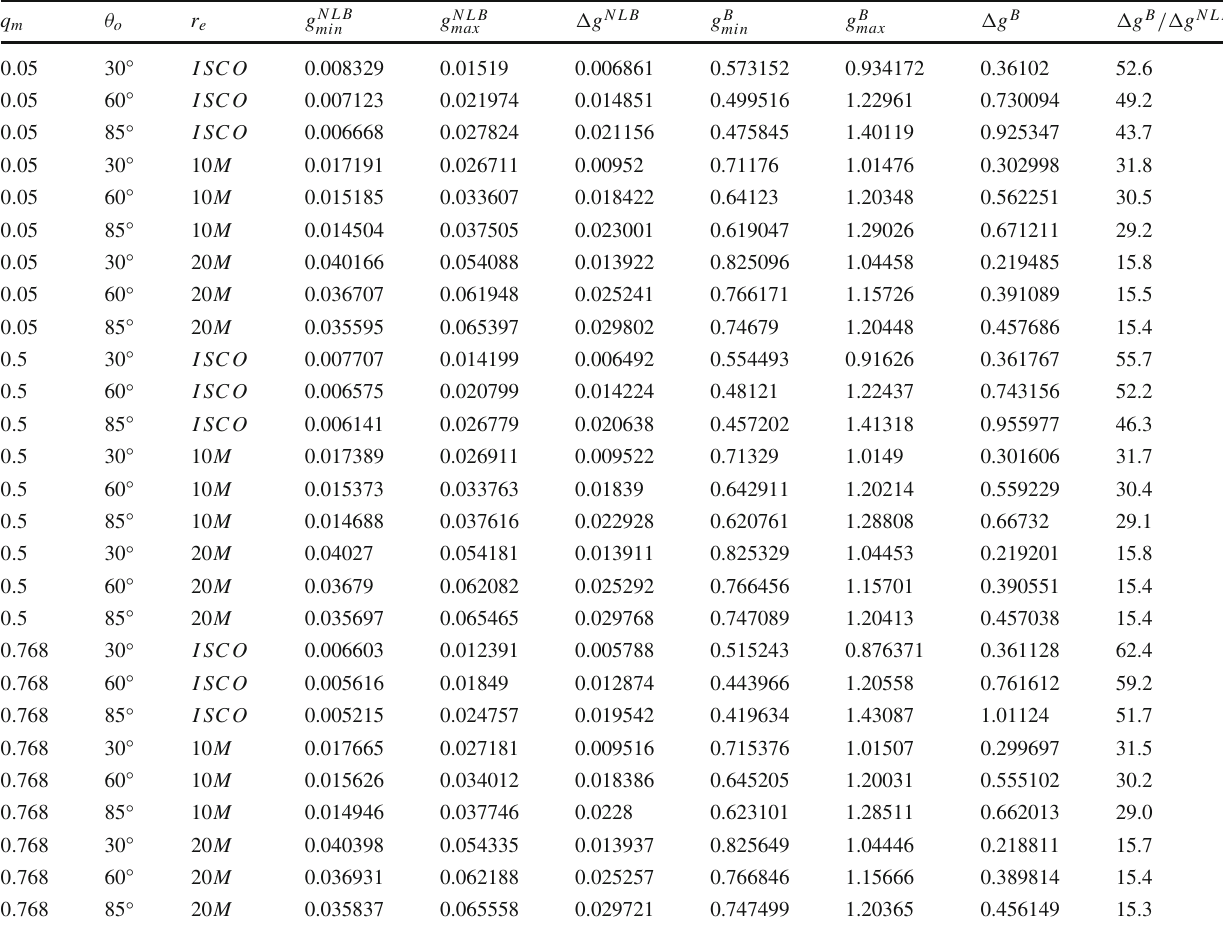
Table 1 The width of profiled spectral line in terms of minimal (maximal) frequency shift g min ( g max ), (cid:13) g ≡ g max − g min . The spacetime “magnetic charge” parameter – q m , observer inclination – θ o , and Keplerian ring radius – r